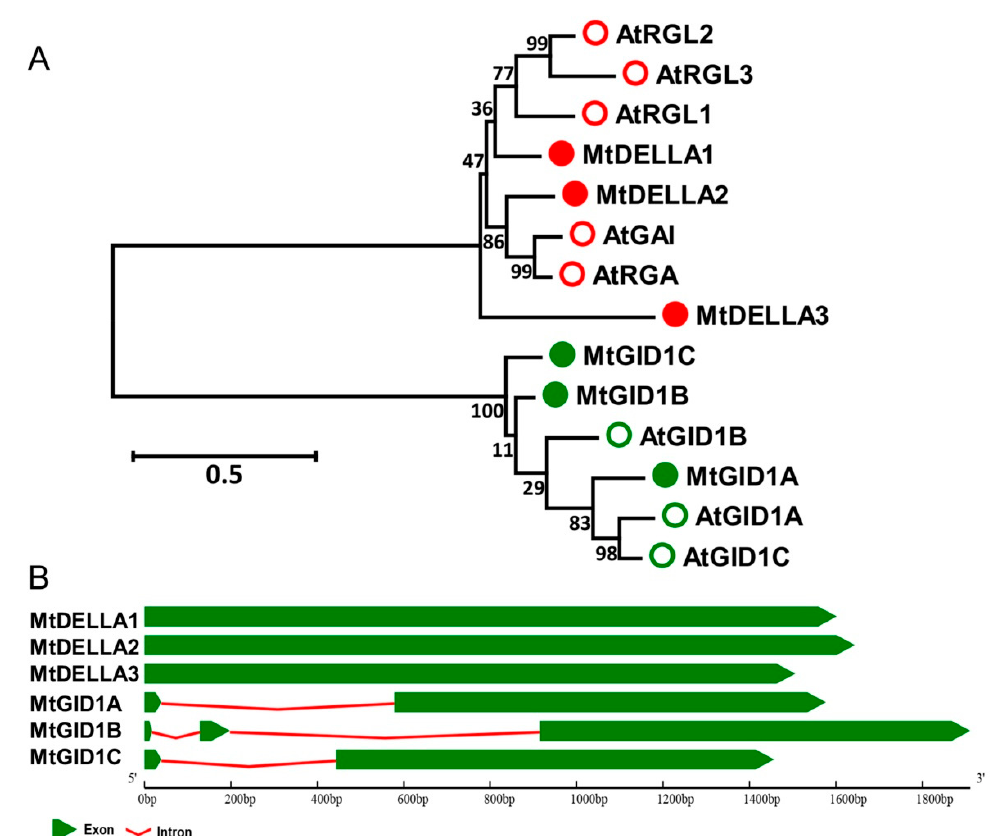
Figure 4. Phylogenetic tree analysis and exon-intron structures of the DELLA and GID1 gene family. ( A ) Phylogenetic analysis of DELLA and GID1 proteins from A. thaliana and M. truncatula . The tree is generated with MEGA 7.0 software using the Neighbor-Joining (NJ) method. The bootstrap analysis was conducted with 1000 iterations. The values on the phylogenetic tree represent the result of bootstrap analysis conducted with 1000 iterations. The scale bar indicates that the sequence divergence is 0.05 per unit bar, which represent 5% substitutions per nucleotide position. The empty and full circles in red color represent A. thaliana and M. truncatula DELLA proteins and the empty and full circles in green color represent A. thaliana and M. truncatula GID1 receptor proteins ( B ) The gene structures of the MtDELLAs and MtGID1s . Exons are represented by green boxes; introns are shown as red lines.